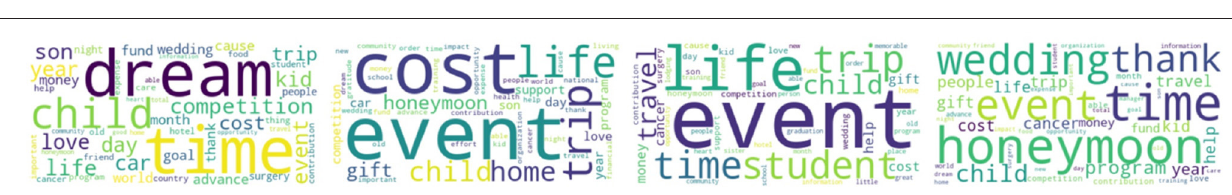
FIGURE 3 | Topics under the Other category that had significant effect on success before the COVID-19 outbreak. We generate four topics with the best coherence value: 0.35192.